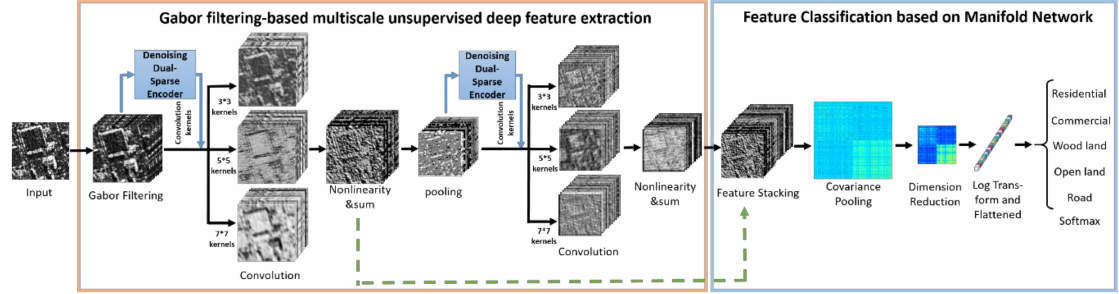
Figure 2. Framework of the proposed method for high-resolution synthetic aperture radar (HR SAR) image